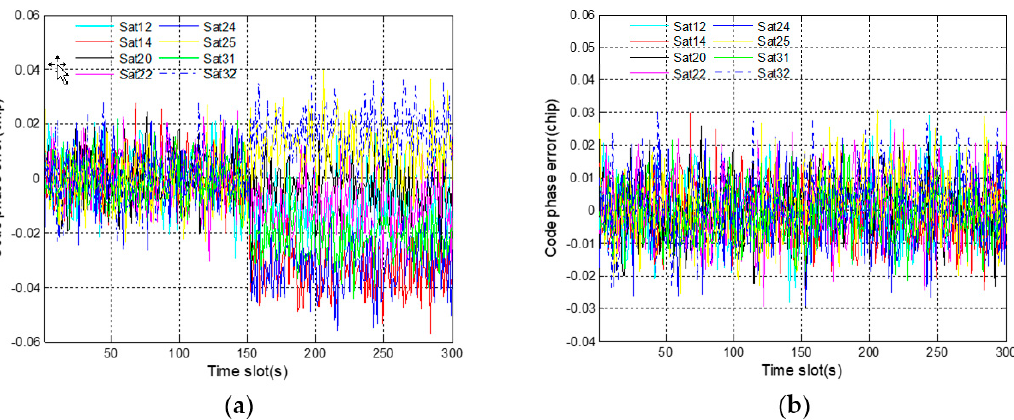
Figure 11. Code phase errors of eight satellite signals corresponding to abrupt fault: ( a ) before using a robust algorithm; ( b ) after using a robust algorithm.